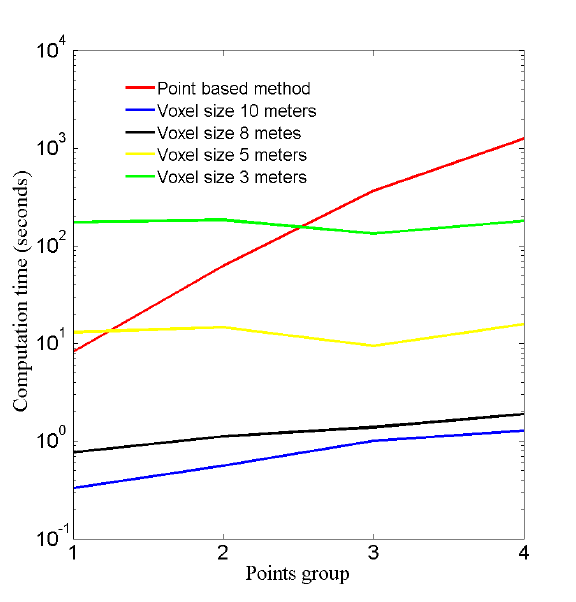
Figure 9: Computation time of the two methods